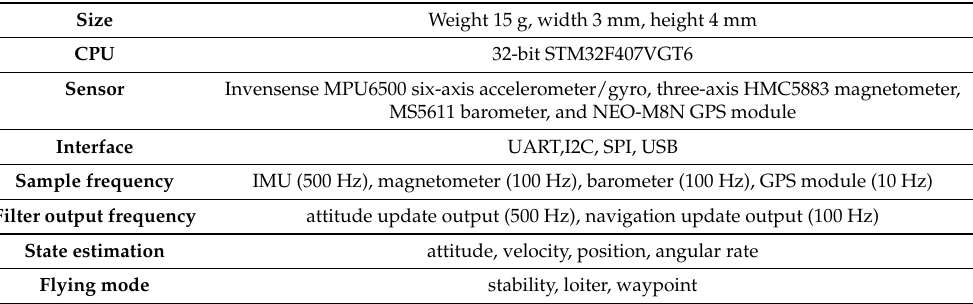
Table 3. The self-designed flight control autopilot specifications.